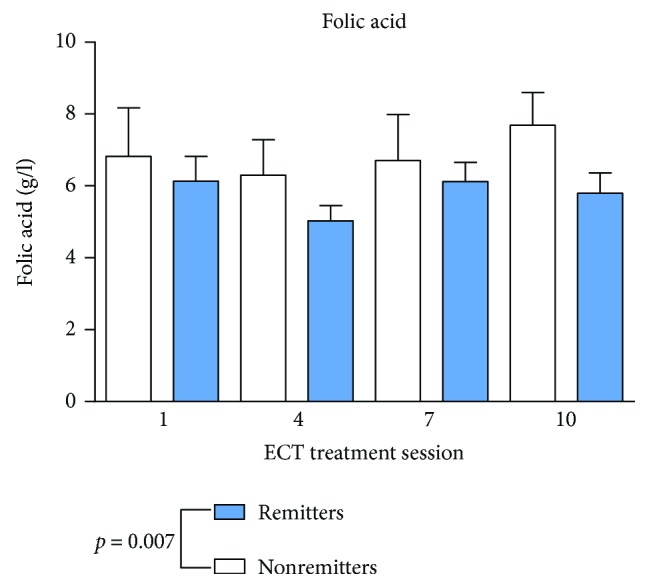
Folic acid serum levels in remitters and nonremitters. Mixed linear modelling showed significantly lower serum levels of folic acid in remitted patients. The p value given in the figure is derived from mixed linear modelling. Error bars show the standard error of the mean (SEM).